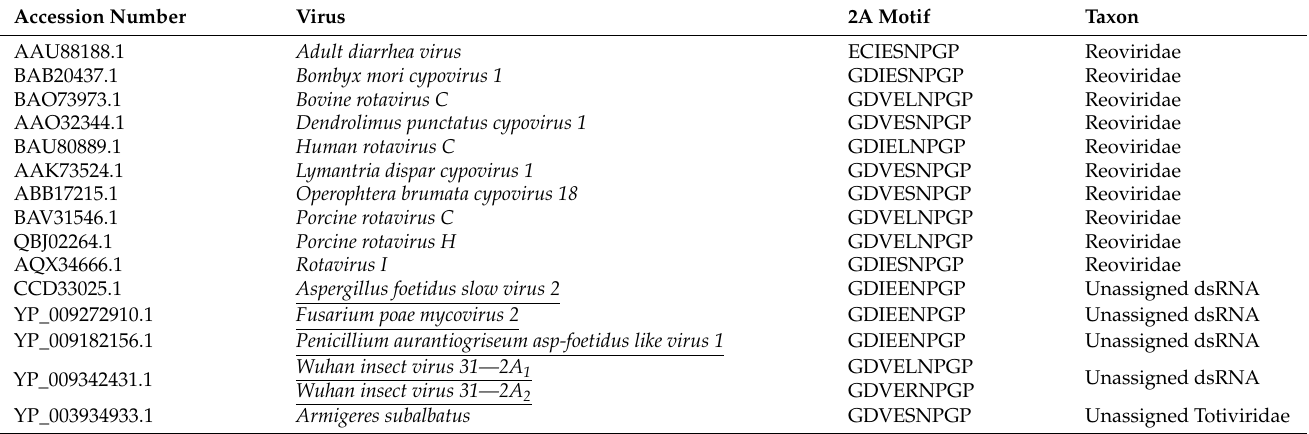
Table 3. Double-stranded RNA viruses identified in this study containing 2A-like